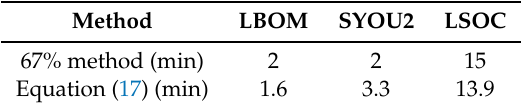
Table 6. Level of magnitude of the time constant calculated using Equation (17) and observed using the 67% method during the time period identified Figure